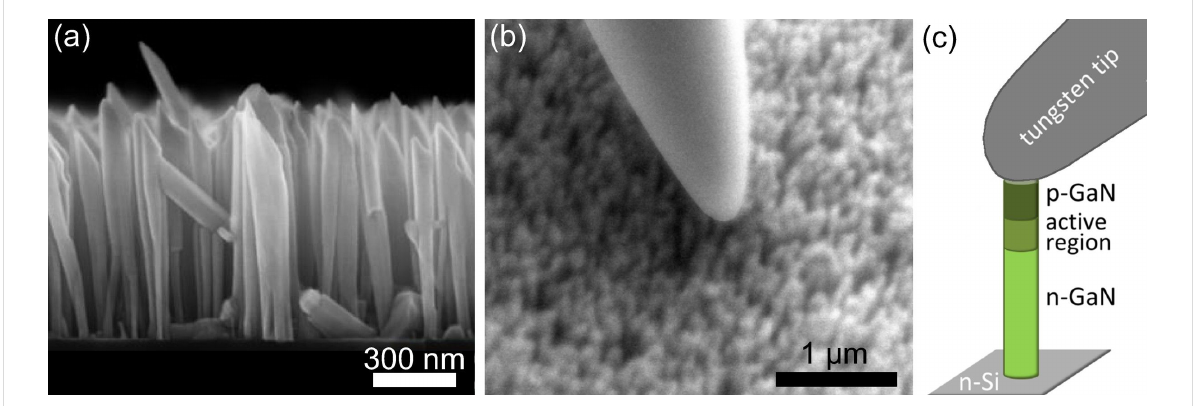
Figure 1: (a) Cross-sectional micrograph of the investigated self-assembled GaN NW LEDs on Si acquired in the field-emission SEM. (b) Bird’s-eye view micrograph of a probe tip contacting single NWs taken in the thermionic emission SEM with a magnification at the edge of the resolution. (c) Sketch of a tungsten probe tip contacting a NW LED.